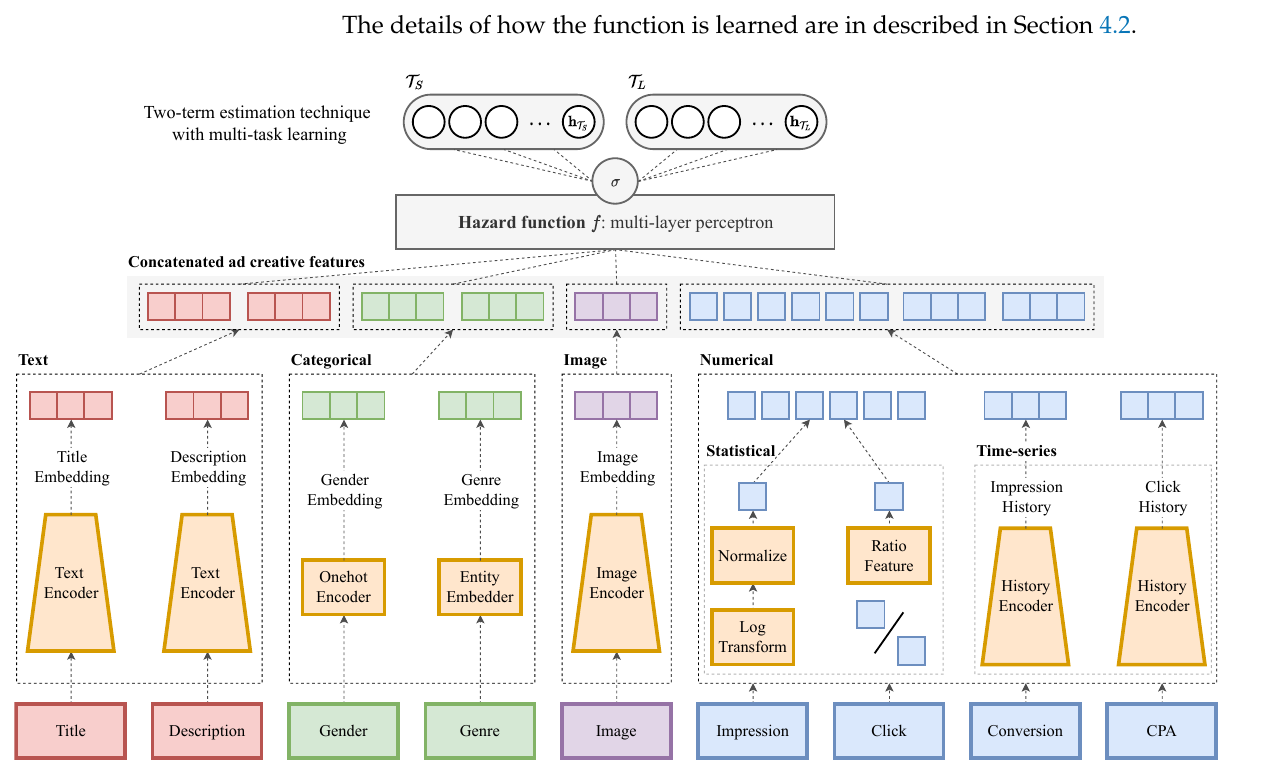
Figure 3. Outline of our framework that exploits a hazard function, which draws on the idea of survival prediction, to predict the discontinuation of ad creatives. The input includes the four types of features: text, categorical, image, and numerical features. The output is the hazard probability, which includes whether the target ad creative has been discontinued in each time